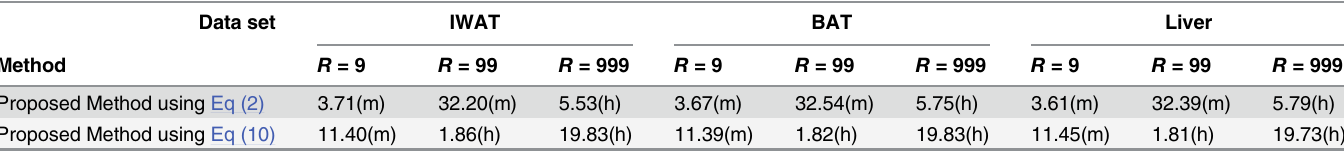
Table 2. IWAT, BAT and Liver data sets: timings (in minutes (m) or in hours (h)) for the proposed method and a variant of it that uses a set of 60 cosine waves with smaller phases generated using the Eq (10). The number of bootstrap replications R is in {9, 99, 999}. Data set IWAT BAT Method Proposed Method using Eq (2)